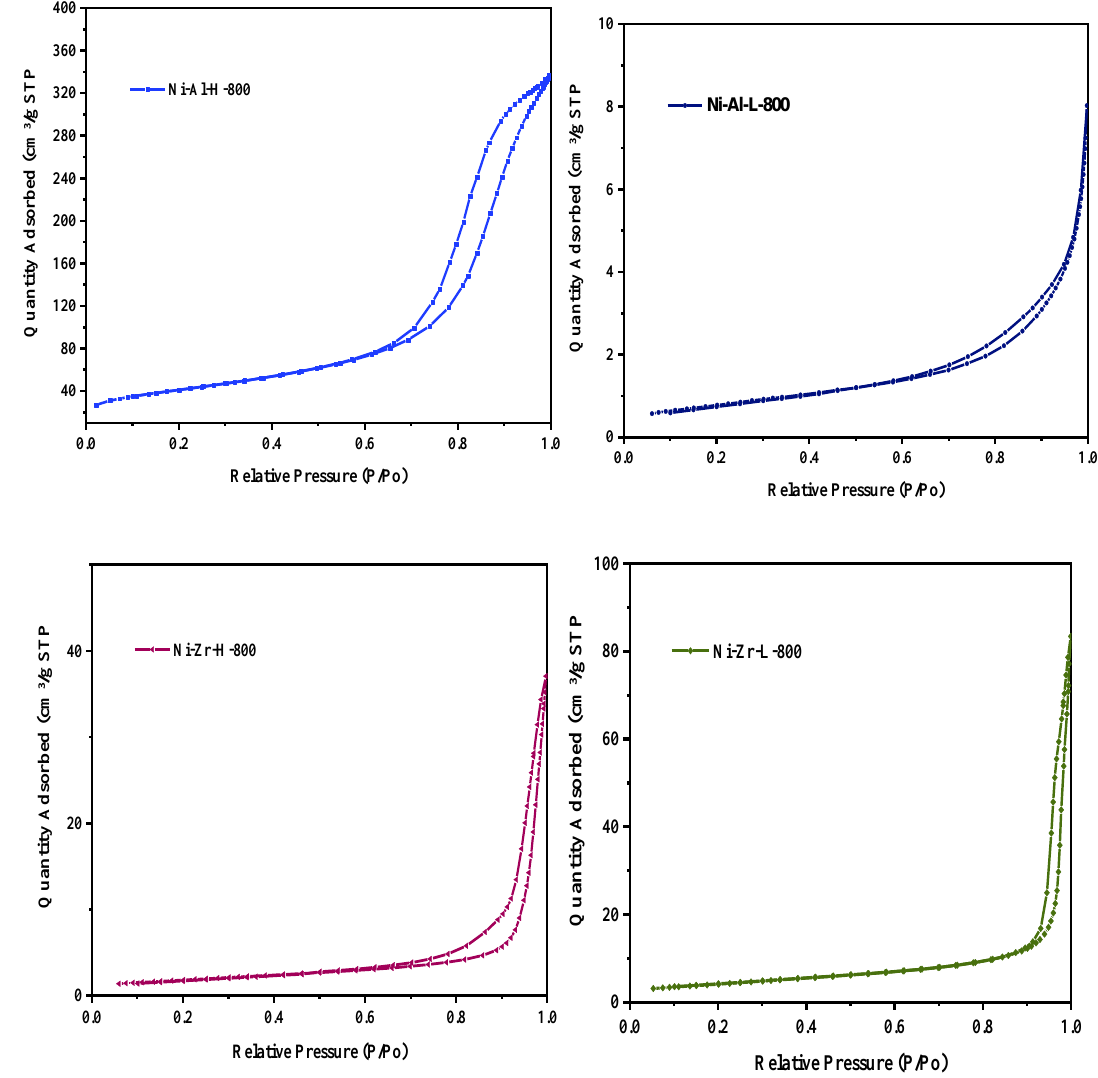
Figure 2. Nitrogen adsorption/desorption isotherms of fresh catalysts calcined at 800 °C.